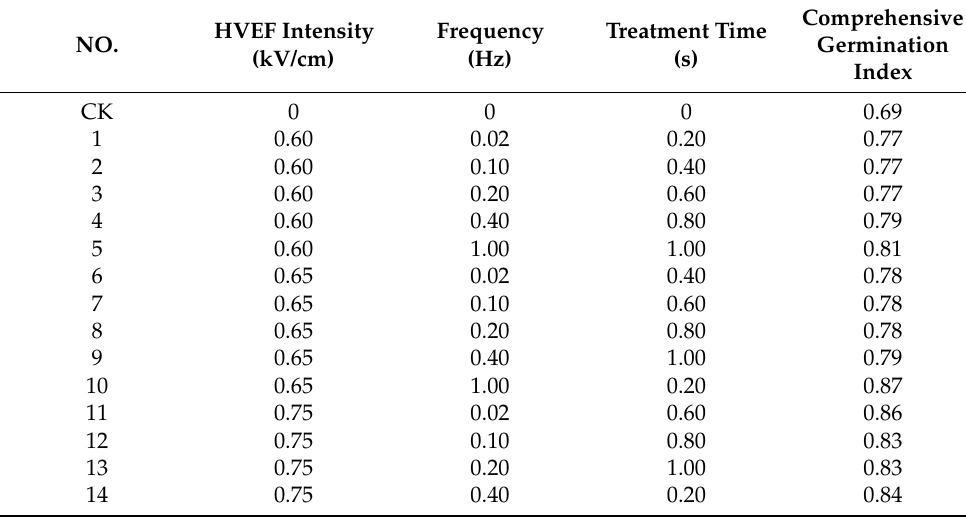
Table 3. Normalization of the orthogonal experiment